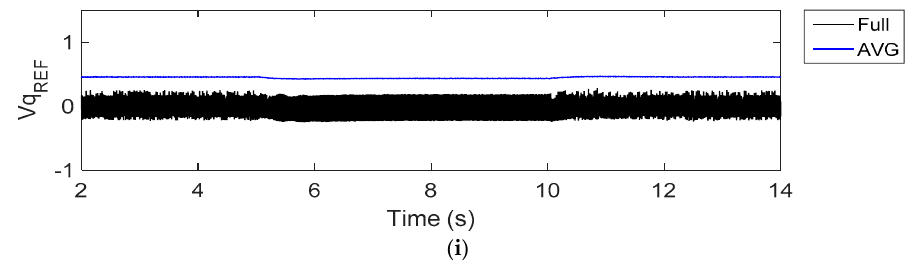
Figure 13. Outputs when wind speed change of 11.5 m/s to 10.5 m/s back to 11.5 m/s with unbalanced loads connected to DFIG Bus. ( a ) active power outputs, ( b ) reactive power outputs, ( c ) load bus voltage, ( d ) DC voltage, ( e ) DFIG speed, ( f ) I d , ( g ) I q , ( h ) V d , ( i ) V q .